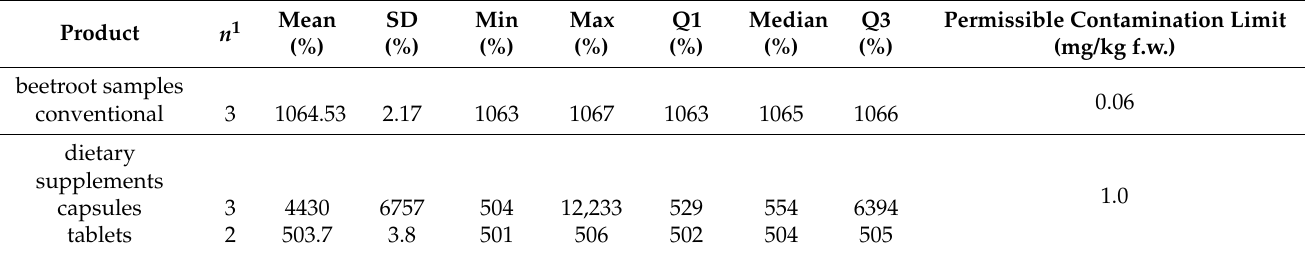
Table 7. Determined content of Cd in beetroot and dietary supplement samples expressed as a percentage of the maximum allowable level of its